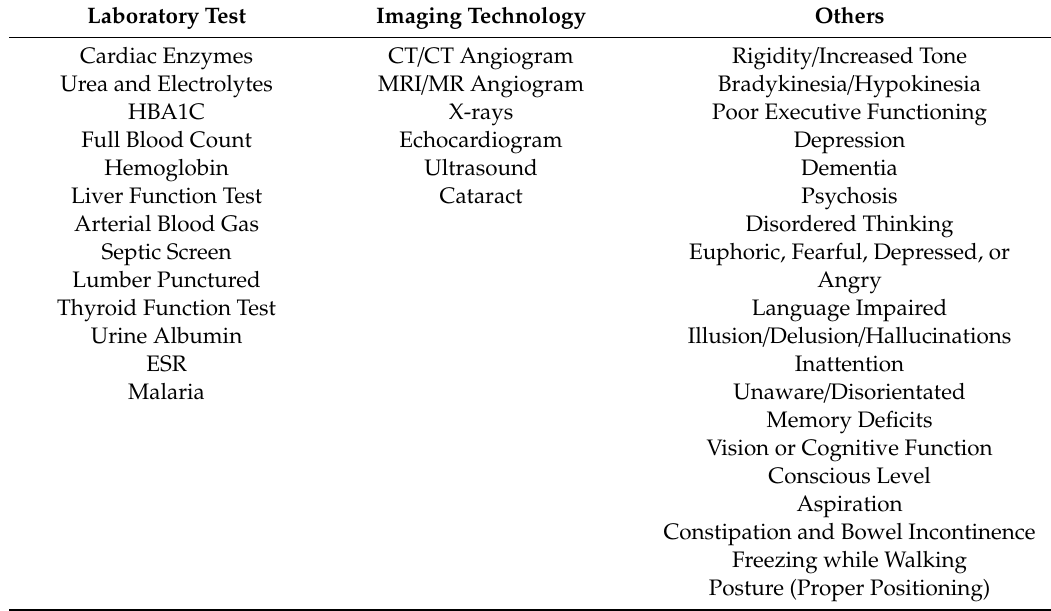
Table 2. List of data types that cannot be collected by the available IoT